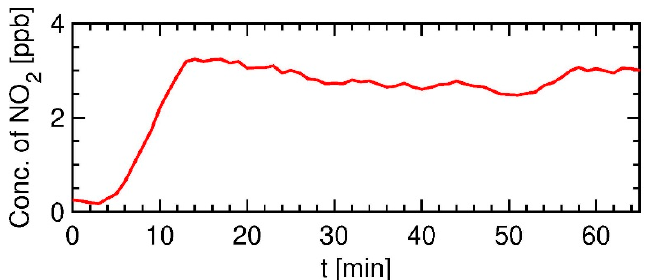
Figure 3. Valve A is switched from N 2 to NO 2 . Due to the low flow rate of the smallest orifices, 30 min waiting time is necessary for achieving a stable